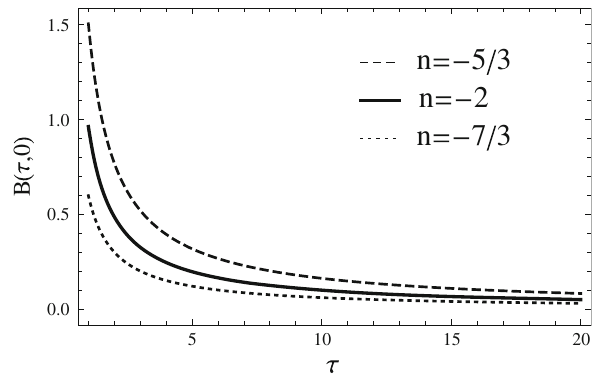
Fig. 10 Magneticfield B (τ, x ) versus τ plotat x = 0 fmwithdifferent values of n . The dashed, solid and dotted curves correspond to n = − 5 / 3 , − 2 and − 7 / 3, respectively